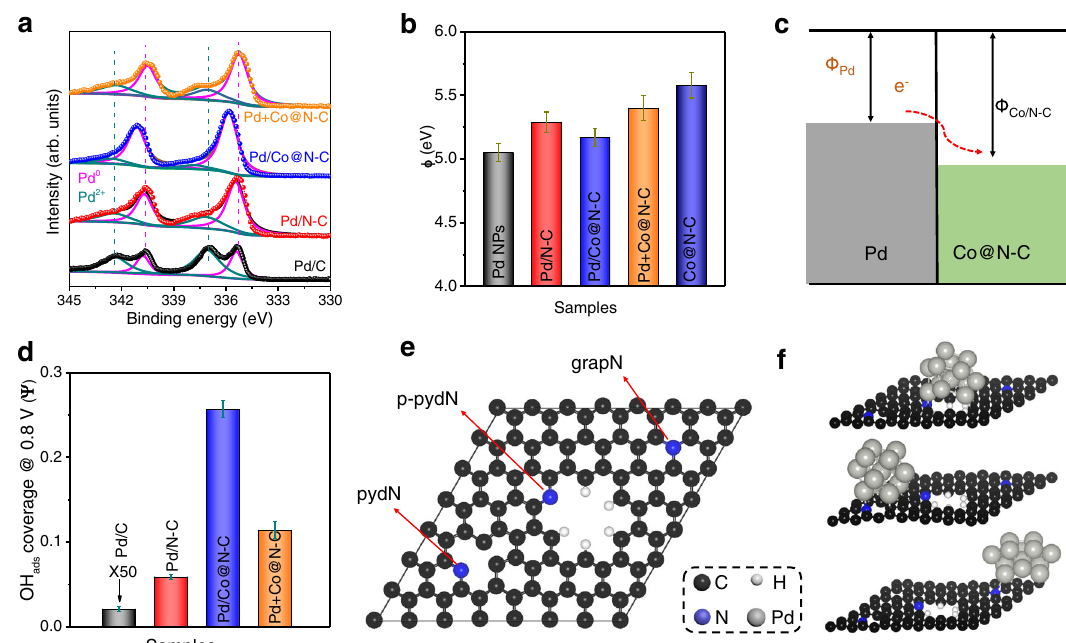
Fig. 2 | Strong electronic effect between Pd and Co@N-C. a Pd 3 d XPS spectra. b The WF ( ɸ ) of Pd/C, Pd/N-C, Pd/Co@N-C, physically mixed Pd+Co@N-C, and Co@N-C support, respectively. c Schematic illustrations of electronic interfacial interactionsoccurringbetweenPdandCo@N-C. d Theoxygenophilicpropertiesat 0.8 V RHE for different samples. The error bars in ( b ) and ( d ) represent the s.d. of at